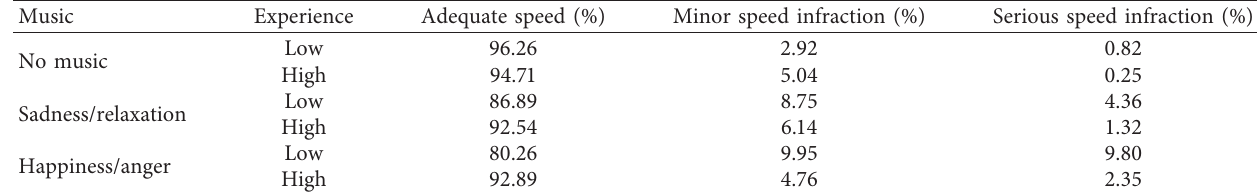
Table 8: Probability of speed infraction depending on the music type and experience steering wheel.